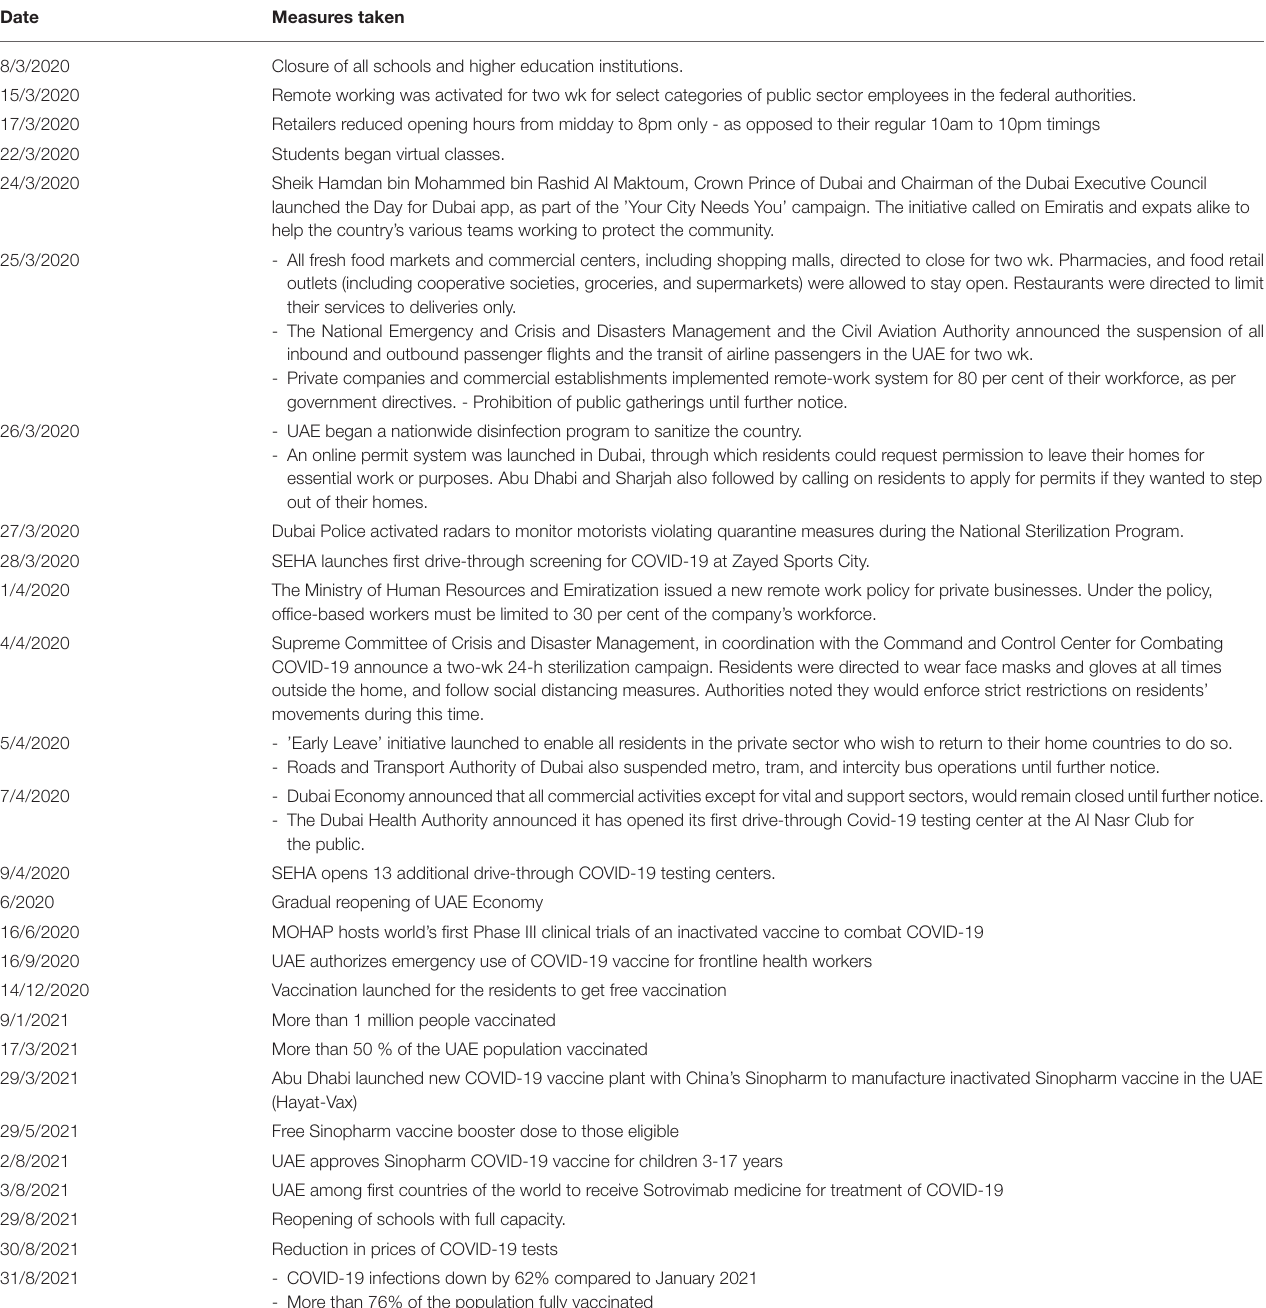
TABLE 1 | The proactive measures taken by the UAE leadership and NCEMA to limit the spread of the coronavirus disease.